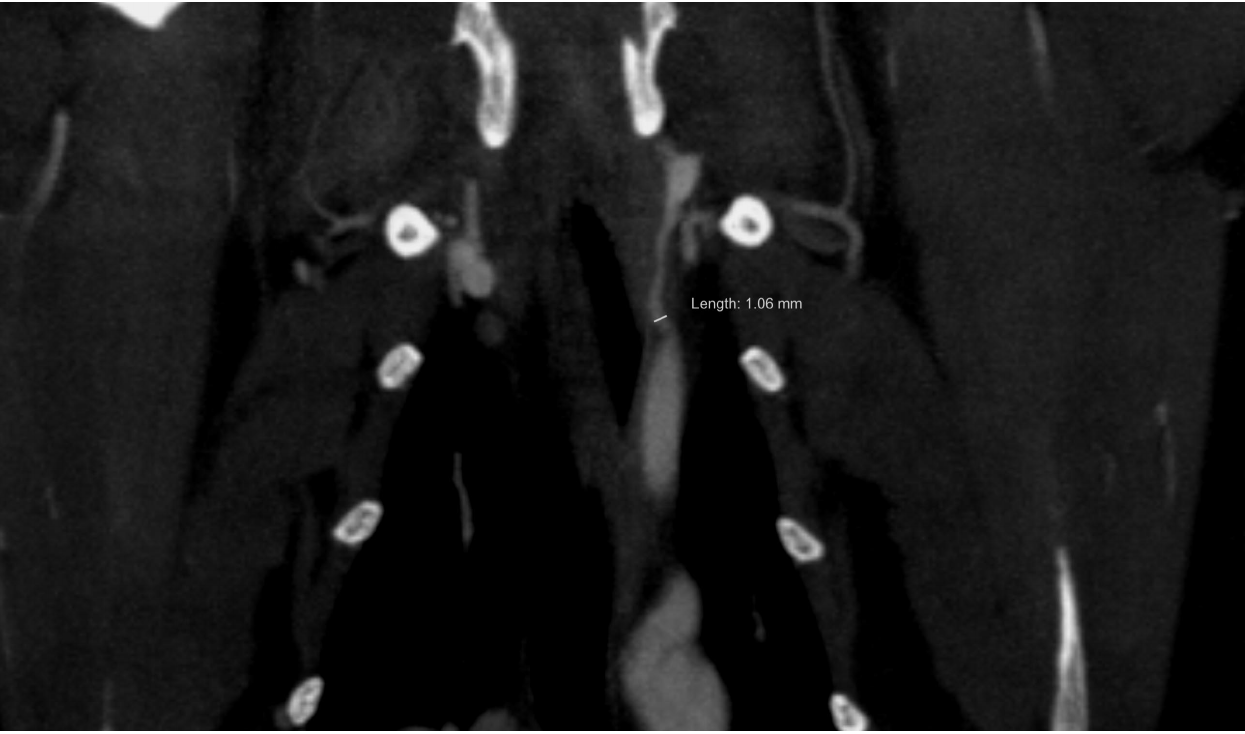
Figure 7. Measurement of the stenosis in the coronal view made by expert